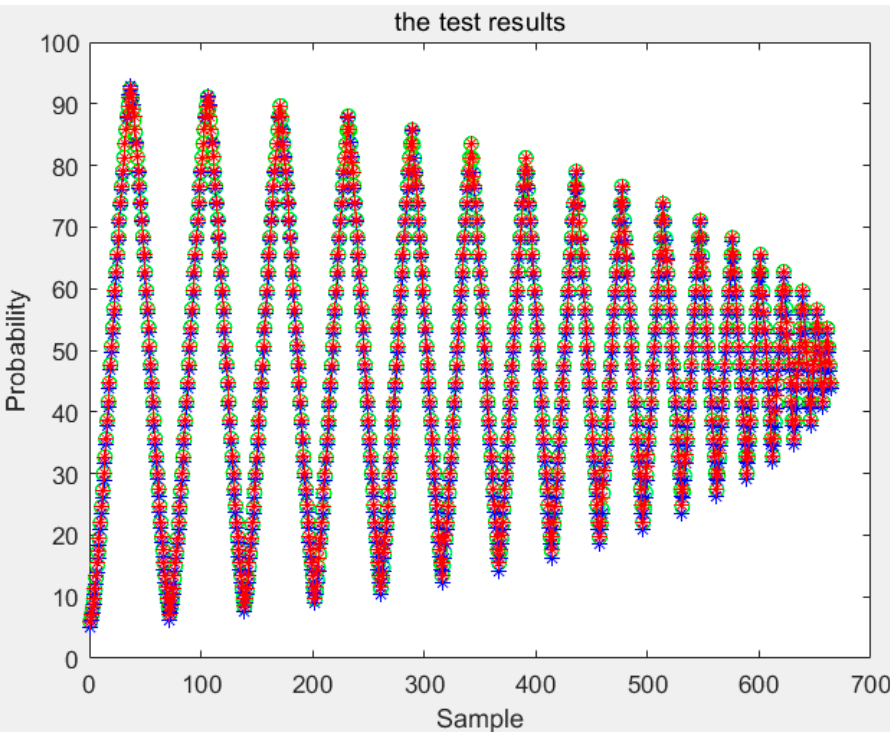
Sensors 2021 , 21 , x FOR PEER REVIEW Figure 18. Test results of the second kind sensor for the sparse data. Figure 18. Test results of the second kind sensor for the sparse data.